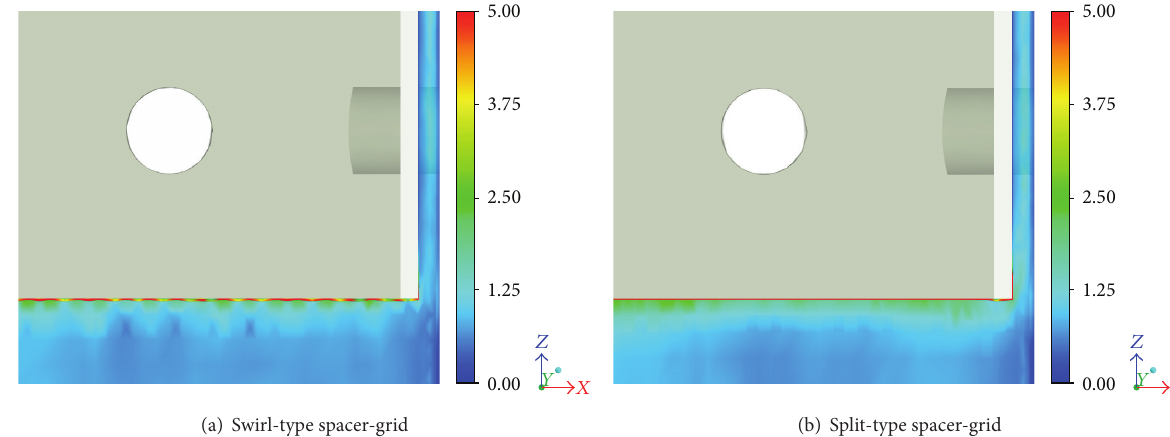
Figure 11: Local effects on the courant number.